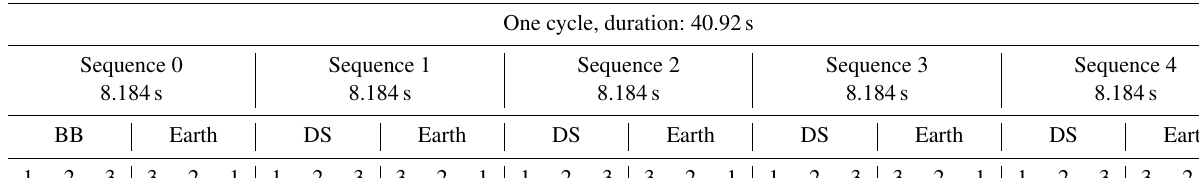
Table 1. IIR acquisition timing for one cycle (see text).